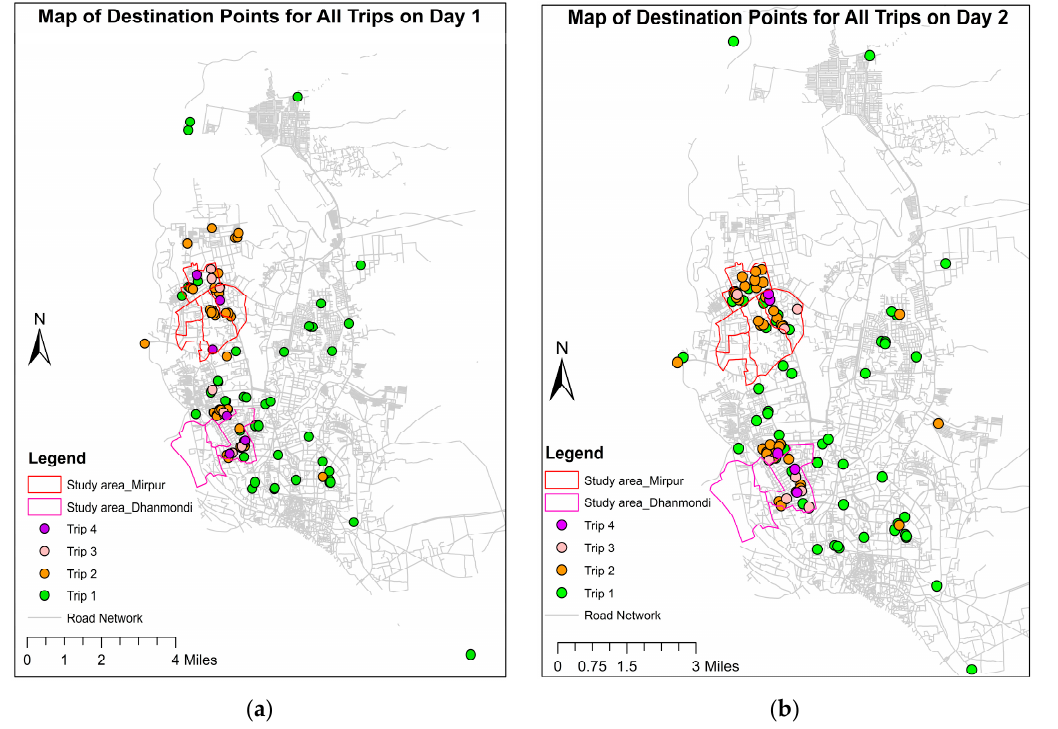
Figure 5. Distribution of trip destination points for all the trips of two working days; ( a ) Day 1 and ( b ) Day 2. Shortest-Path Network with Road Network Buffer. Urban Sci. 2019 , 3 , x FOR PEER REVIEW